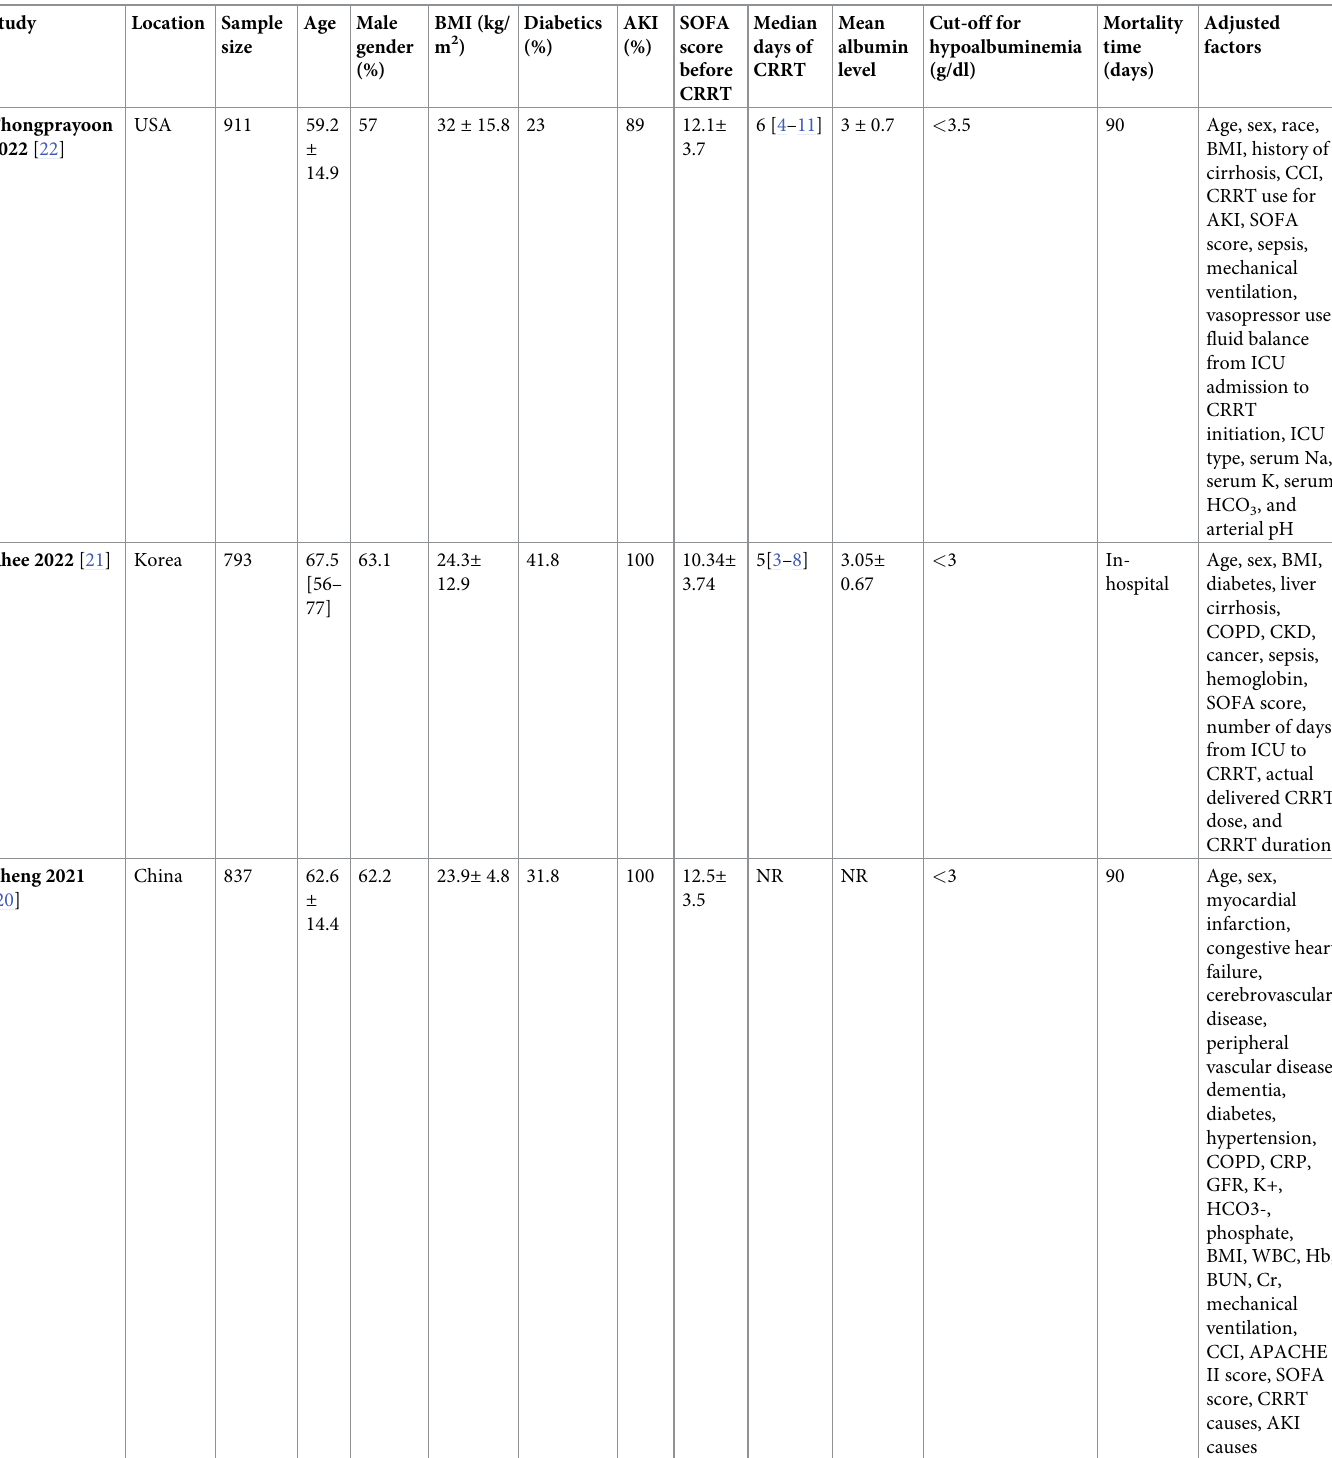
Table 2. Details of included